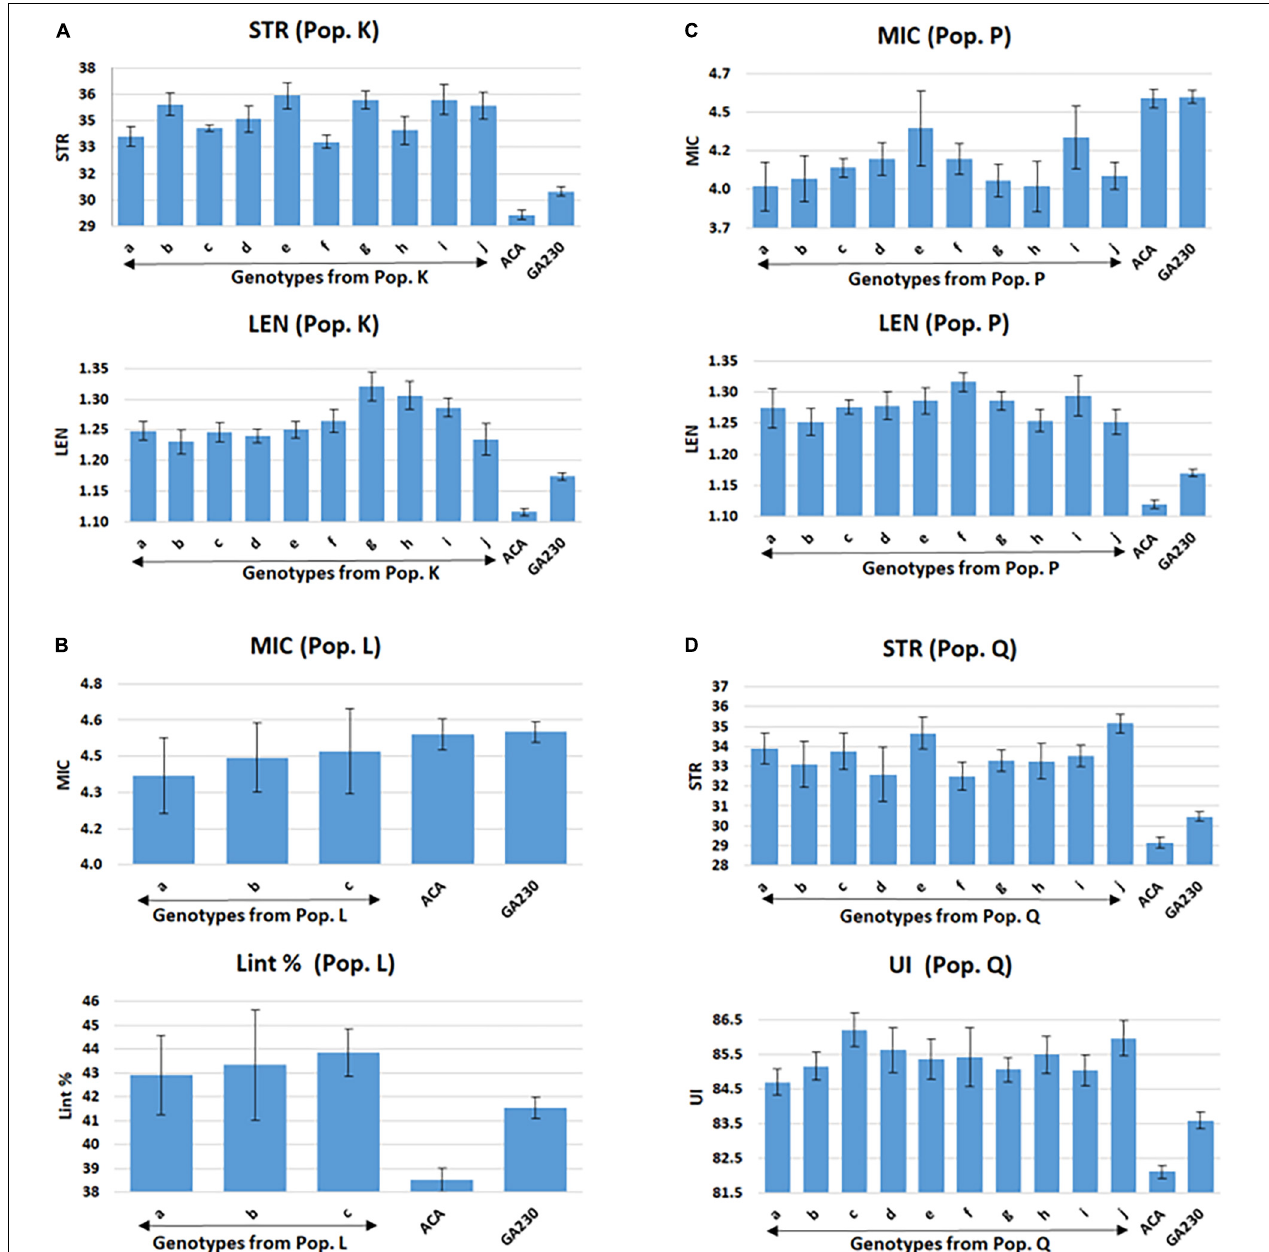
FIGURE 4 | Selected lines showing improvements over parental lines for both targeted fiber traits in populations from ACALA1517-99 (mutant) × GA230. (A) Population K (LEN and STR), (B) population L (MIC and Lint %), (C) population P (MIC and LEN), and (D) population Q (STR and UNIF). Common letters in x-axis of the graph indicate same genotype of populations K (graphs A), L (graphs B), P (graphs C), and Q (graphs D). Error bar indicates a standard error